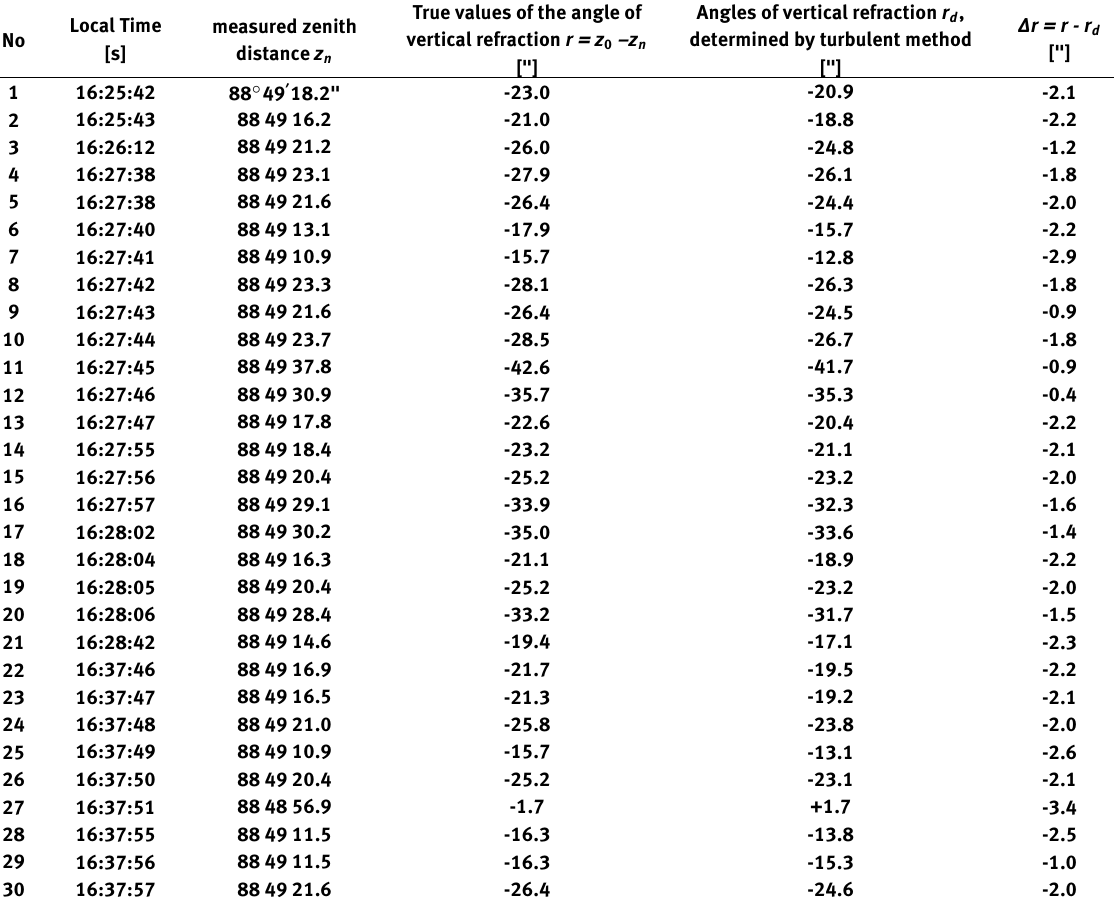
Table 2. Values of the angle of vertical refraction obtained on a line of sights with a length of 765.35 m. True zenith distance z 0 = 88 ◦ 48 ′ 55.2 ′′ , on October 6,